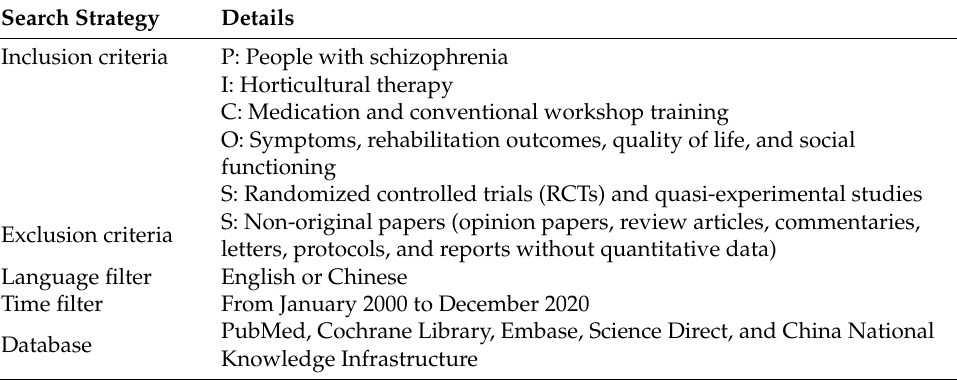
Table 1. Description of the inclusion/exclusion criteria according to population, intervention, comparison, outcomes, and study design (PICOS).